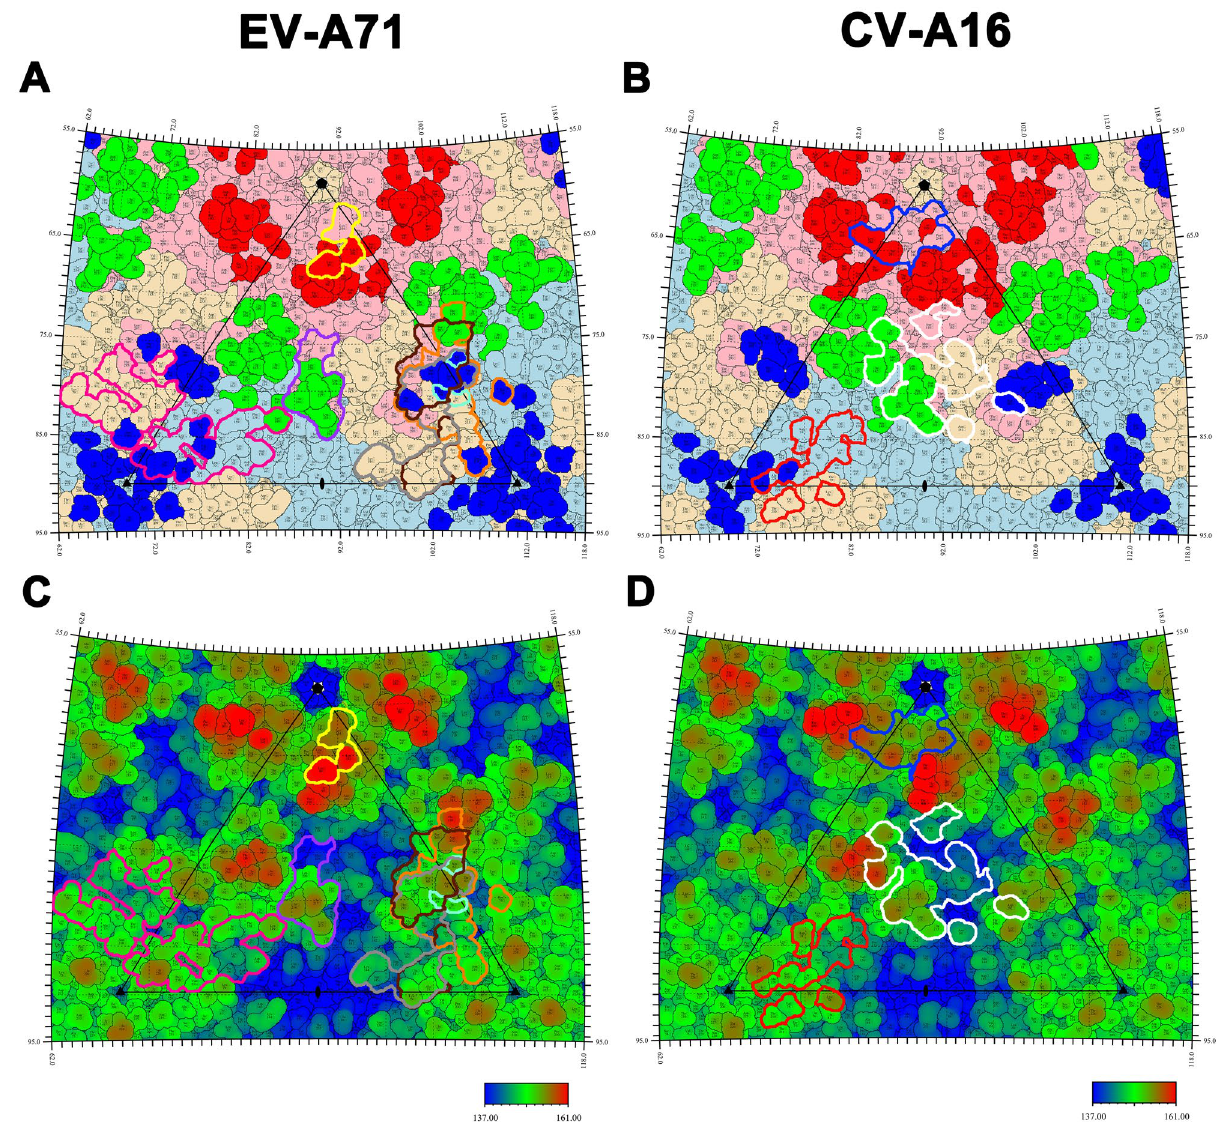
Figure 3. Antibody footprints on the capsid surface of EV-A71 and CV-A16. The capsid surfaces of EV-A71 and CV-A16 are shown as stereographic projections. An icosahedral subunit is outlined by the triangular boundary and the locations of five, three, and twofold vertex are marked as black pentagons, triangles and ovals, respectively. ( A,B ) The residues from VP1 are shown in light pink, VP2 in light blue and VP3 in light orange, respectively; the residues in conformational epitopes site 1, site 2 and site 3 are colored in red, green and blue, respectively. ( A ) The binding sites of seven neutralizing antibodies on EV-A71 are indicated by solid lines in different colors (Mab 28-7: yellow, D5: purple, 10D3: aquamarine, D6: brown, A9: gray, E18: deep pink, E19: orange). ( B ) The binding sites of three antibodies 18A7, 14B10 and NA9D7 on CV-A16 are marked by blue, red and white solid lines, respectively. ( C,D ) The surfaces of EV-A71( C ) and CV-A16 ( D ) are colored radially from blue through green to red from the lowest to the highest. The binding sites of all antibodies of these two serotypes are also outlined, respecting the color rules in ( A,B